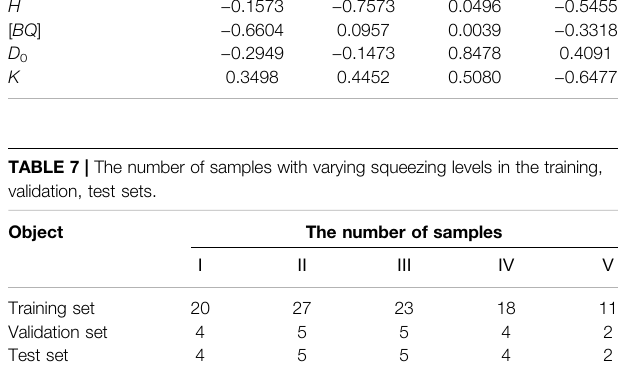
FIGURE 4 | The evolution curve of fi tness function with the number of IGWO iterations.